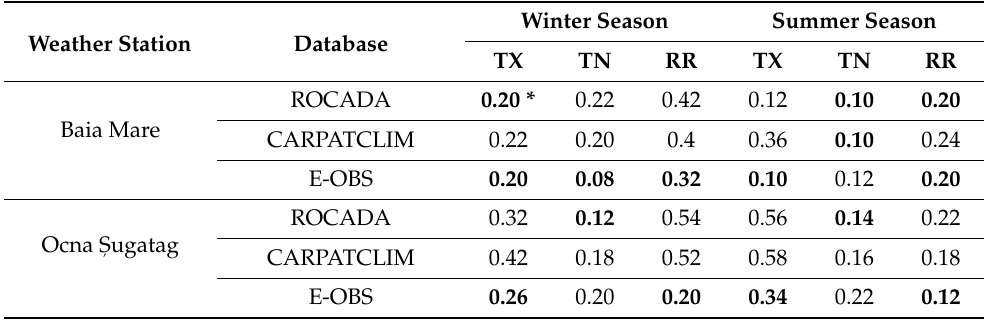
Table 7. The Kolmogorov–Smirnov test (K-S) absolute maximum distribution (D) between the gridded datasets and the observation values for the extreme seasons at the Baia Mare and Ocna Ș ugatag meteorological stations (1961–2010).